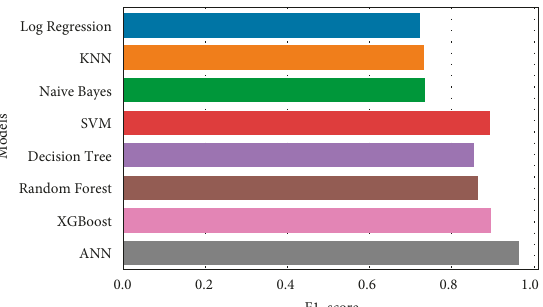
Figure 10: Comparative analysis of F 1-score using different prediction models. Table 5: Comparison of the proposed model with the existing approach. S. No.